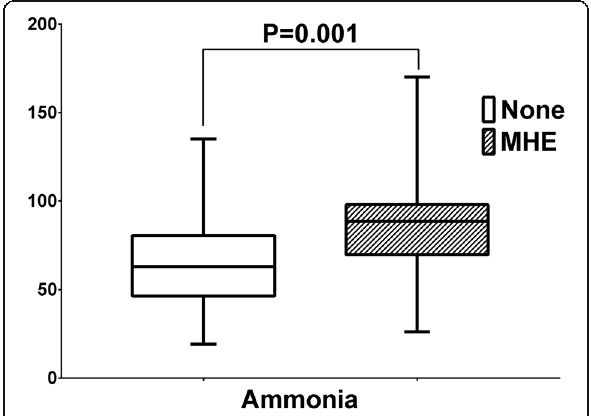
Fig. 2 Comparison of the ammonia in patients with and without MHE